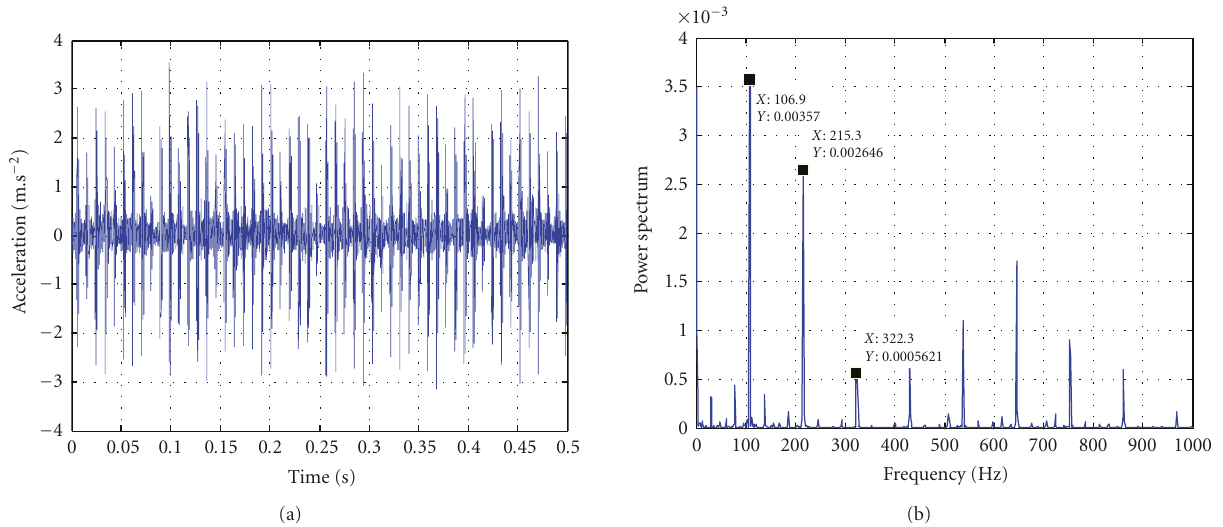
Figure 11: The vibration signal (a) and the corresponding TWPS (b) for rolling bearing with outer-race fault (CWRU data).